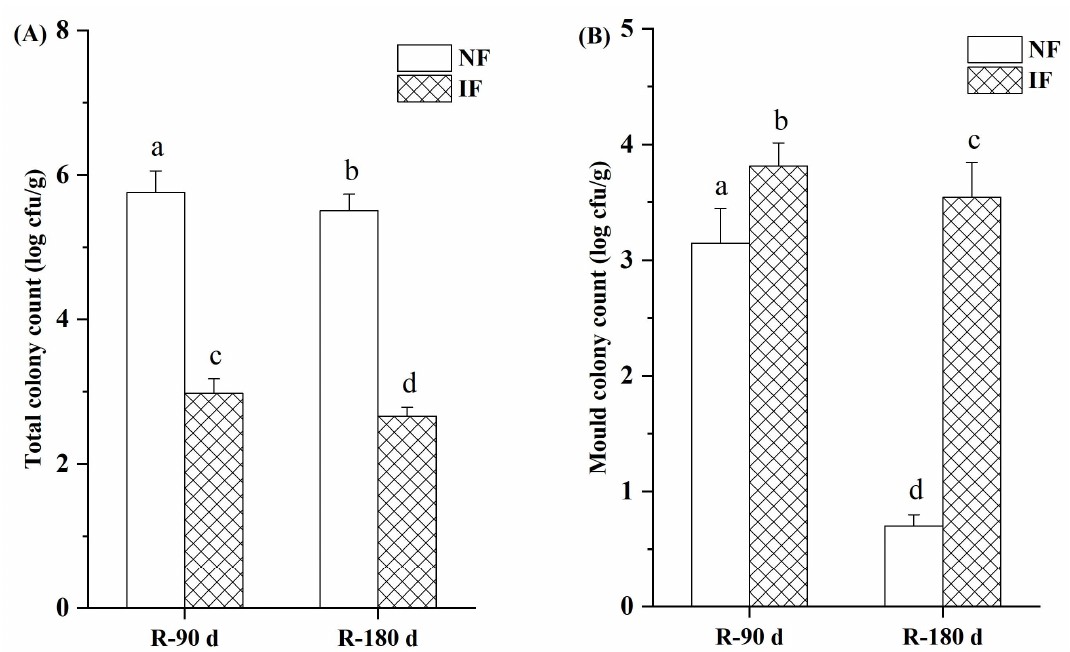
Figure 5. The total colony count ( A ) and mold colony count ( B ) in natural and inoculated fermented sufu at 90 and 180 d of fermentation. Note: Different lower-case letters indicated significant differ- ences at p < 0.05. NF: natural fermentation; IF: inoculated fermentation.